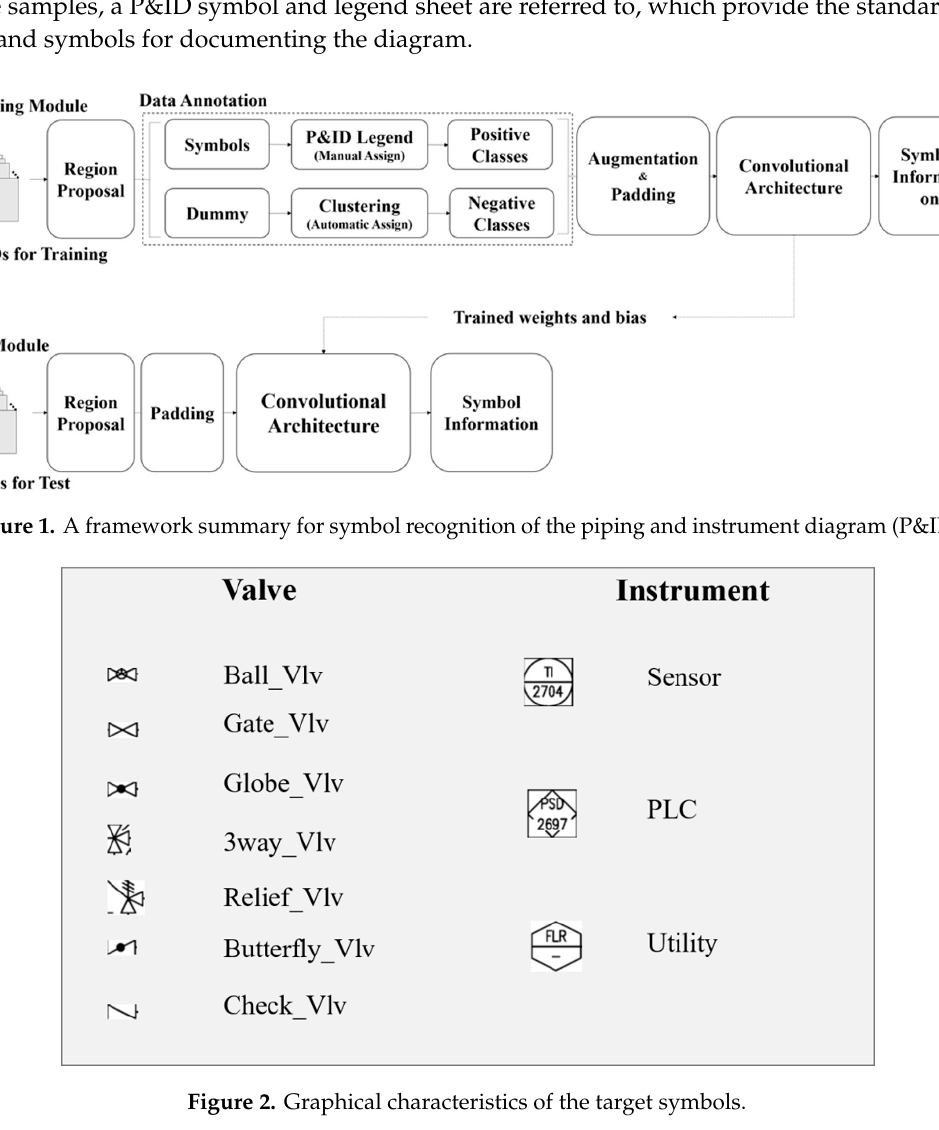
Figure 2. Graphical characteristics of the target symbols.